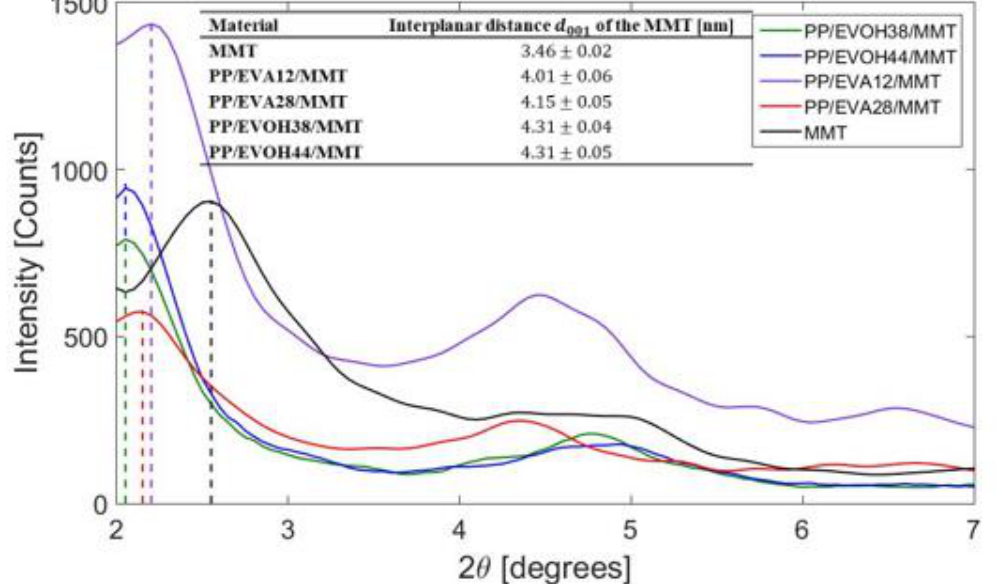
Figure 3. XRD for the MMT and the nanocomposite materials manufactured with different copolymers for the determination of d-space of plane 001 of the clay.